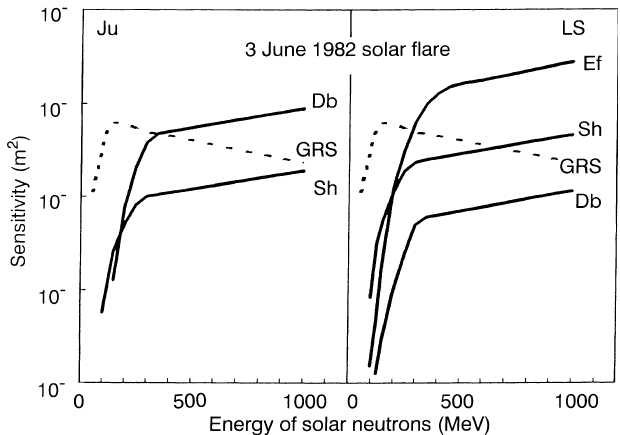
Fig. 4. The sensitivities of Jungfraujoch 18 IGY ( left plot ) and Lomnick (cid:19) y (cid:20) Stit 8NM64 ( right plot ) neutron monitors to solar neutrons for the 3 June 1982 solar-neutron event. The sensitivities are: Db - IGY-D and NM64-D; Sh - IGY-Sh and NM64-Sh; Ef - NM64-E. The sensitivity of the GRS/SMM detector to neutrons is indicated with a dotted